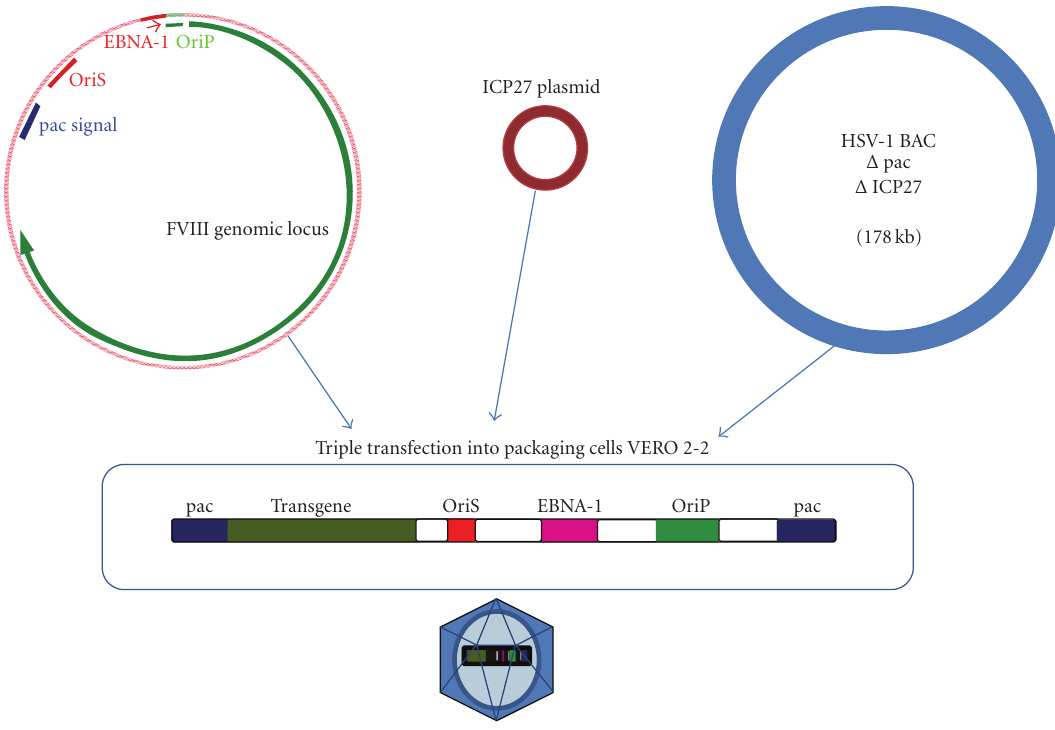
Figure 2: Packaging of OriP/EBNA-1 episomes into herpesviral particles. HSV-1BAC and ICP27 plasmid are the elements used for packaging herpesvirus using the helper-free